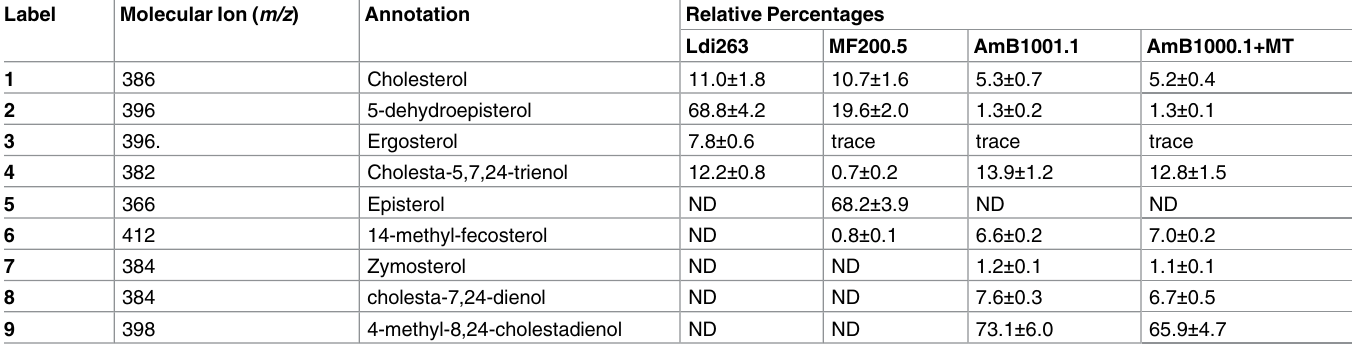
Table 4. GC-MS analysis of sterols in Ldi263, MF200.5, AmB1001.1 and AmB1000.1+MT. Data are the mean ± s.d. of three independentexperiments. Relativepercentages basedupon peak areas. TIC of chromatogram 39.50–43.50 min shown in S8 Fig. ND-not detected. Label Molecular Ion ( m/z